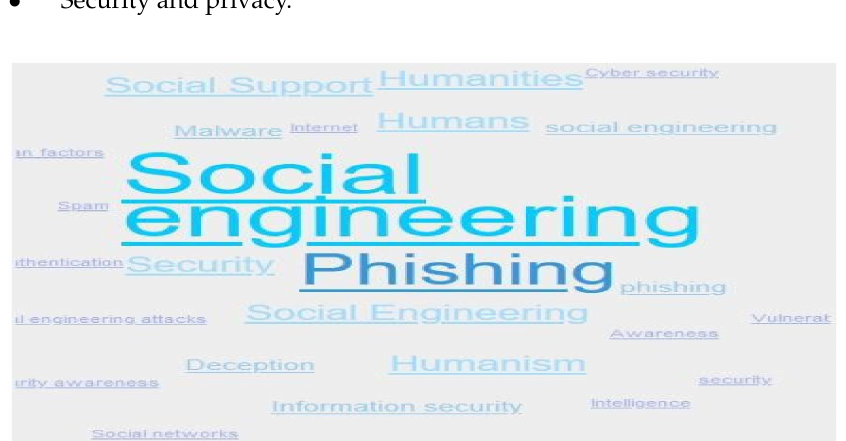
Figure 5. Word cloud of topics related to Social